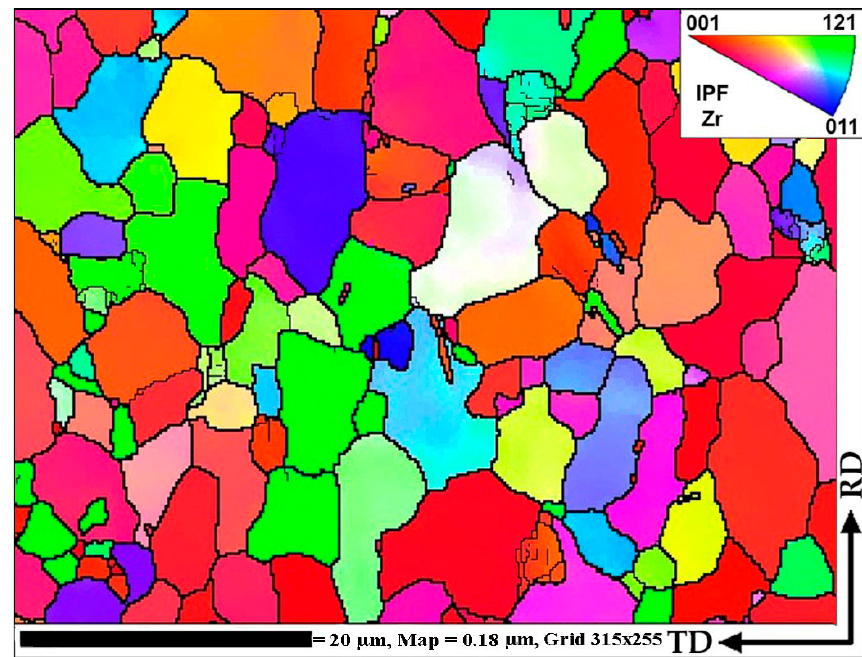
Figure 9. The initial sample structure characterization by EBSD map.